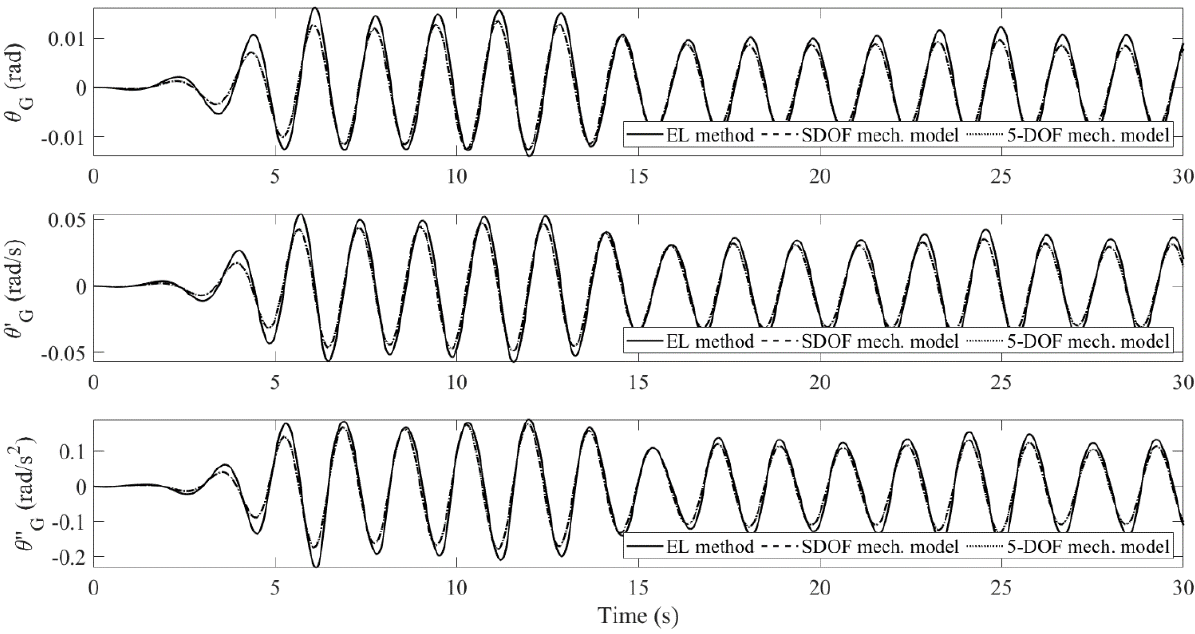
Figure 18. The pitch motion responses of the floating body, configured with a water tank installed with porous media, undergoing small wave excitation.